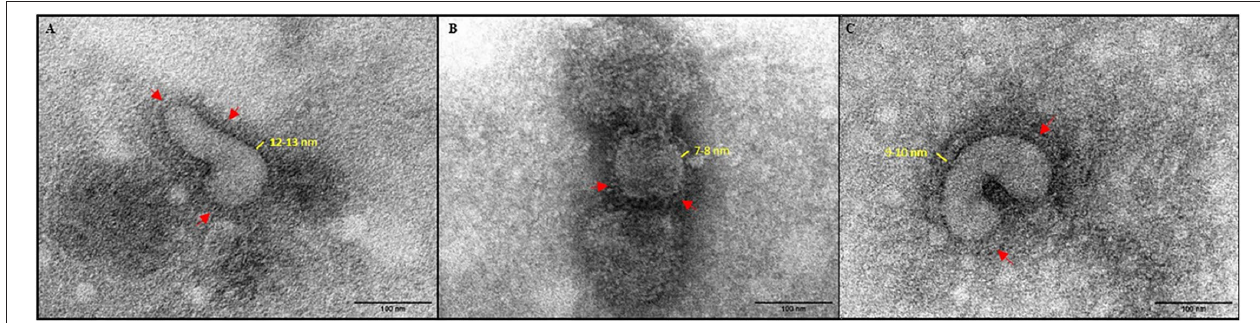
TABLE 1 | BID 50 determination in 6-weeks-old White Leghorn SPF chickens, each infection experiment was performed by oronasal installation of 100 µ L of infectious allantoic fluid diluted in PBS to five ( n = 5) SPF chickens in different isolator units. Challenge dose Positive chickens Negative chickens % of infected